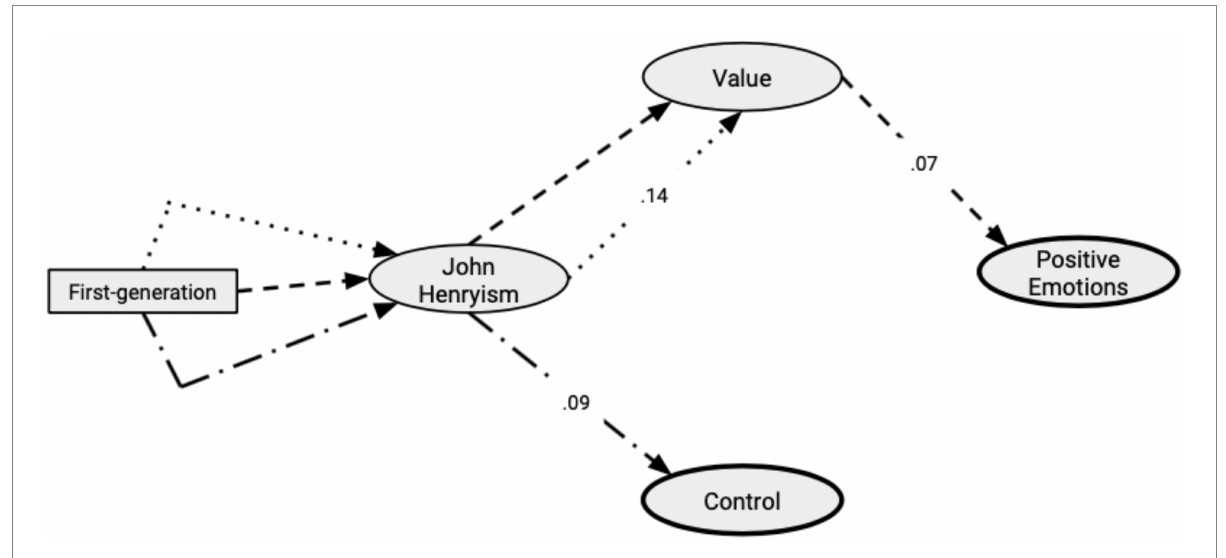
FIGURE 3 Structural equation model with significant indirect